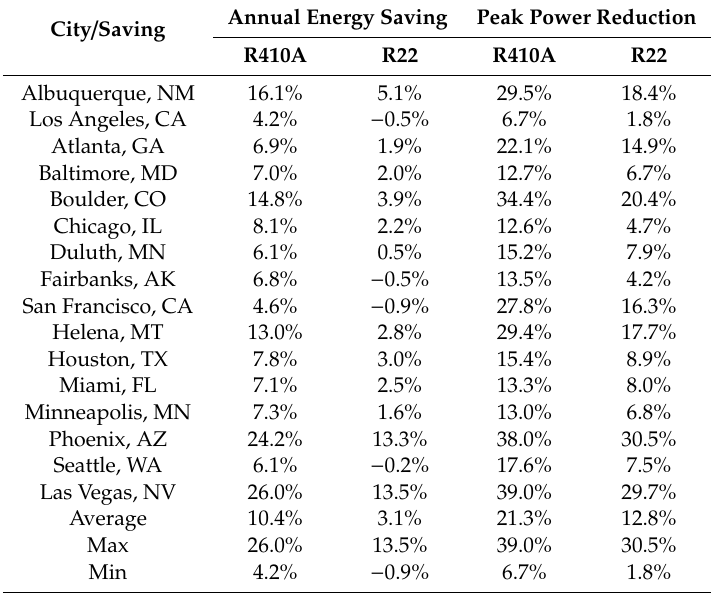
Table 2. Medium o ffi ce building: Annual energy savings and peak power reductions.